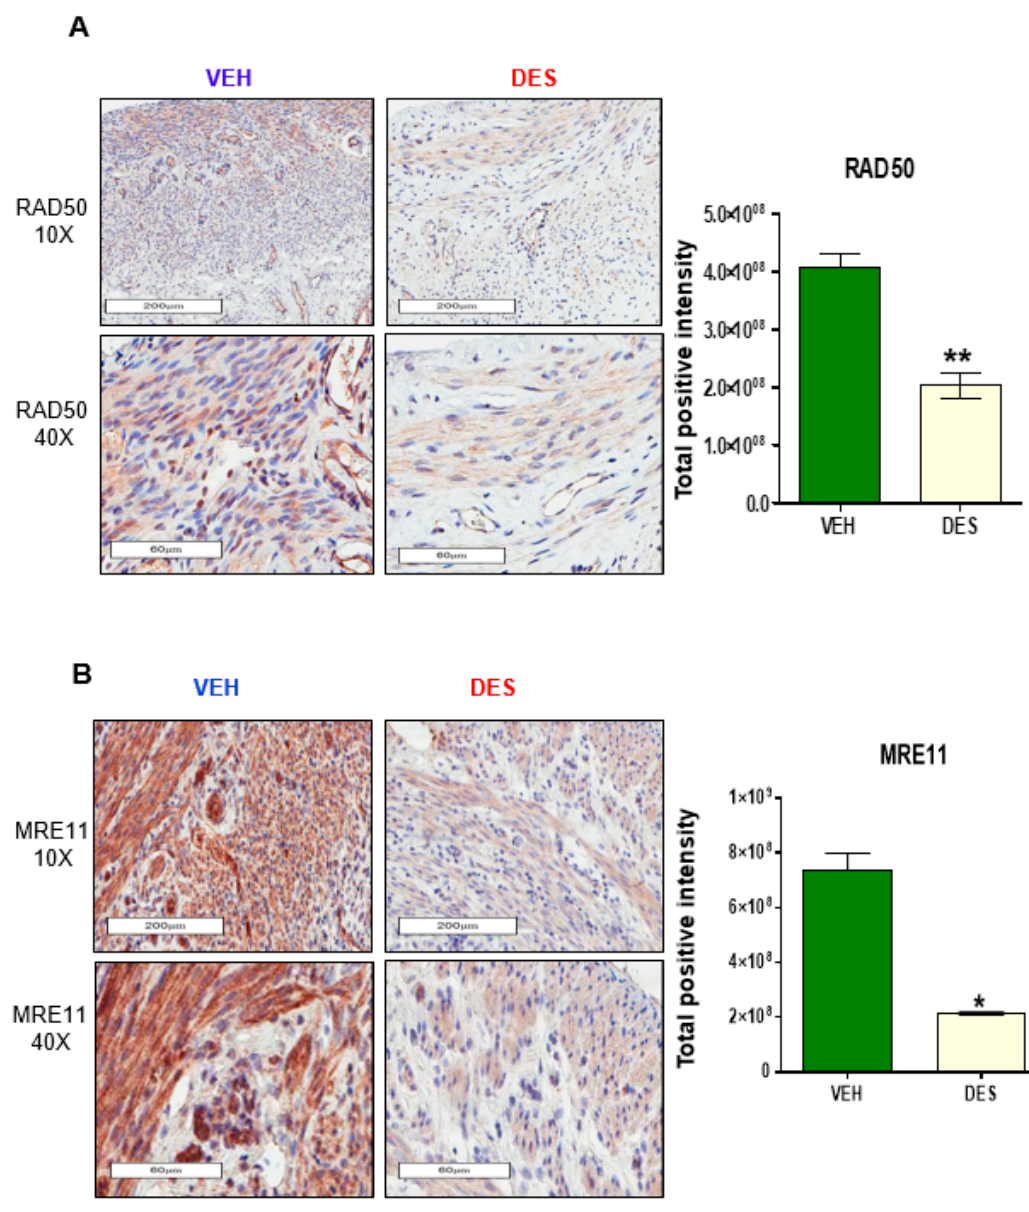
Figure 1. Early-life exposure to diethylstilbestrol (DES) attenuates the expression of RAD50 and MRE11 in rat myometria. ( A ) IHC staining of DNA repair protein RAD50 in myometria of 5-month-old Eker rats at postnatal day (PND) 10–12 exposed to DES and vehicle (VEH) (left panel), and quantitative analysis of RAD50 positive nuclei in DES-exposed vs. VEH-exposed rat myometrial tissue (right panel). ( B ) IHC staining of DNA repair protein MRE11 from the myometria of 5-month-old Eker rats at PND10-12 exposed to DES and VEH (left panel), and quantitative analysis of MRE11 positive nuclei in DES-exposed vs. VEH-exposed rat myometrial tissue (right panel). The percentage of positive cells with brown nuclei was calculated based on the number of stained cells, counted in a total of five random 20× power fields in five DES-exposed Eker rat myometrial tissues and VEH-exposed myometrial tissues (* p < 0.05 ** p < 0.01).